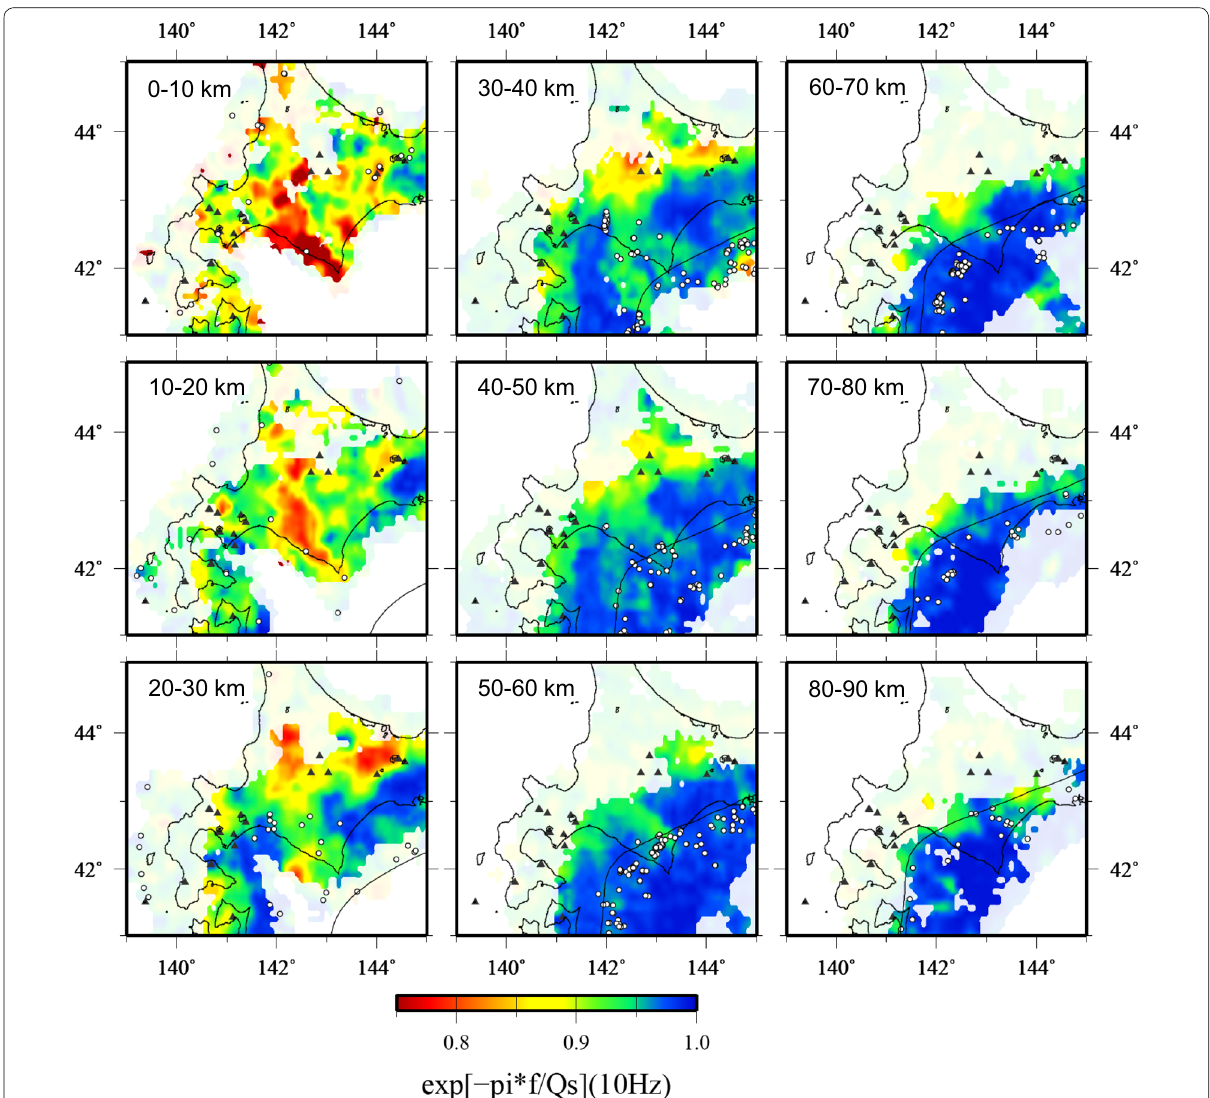
Fig. 2 S-wave attenuation (Qs) structures at depths of 0–90 km in and around Hokkaido, Japan. The frequency, f , is 10 Hz. The well-resolved area, where the restoration index, RI, is greater than 0.001. White circles denote the earthquakes used in this study. Black triangles are